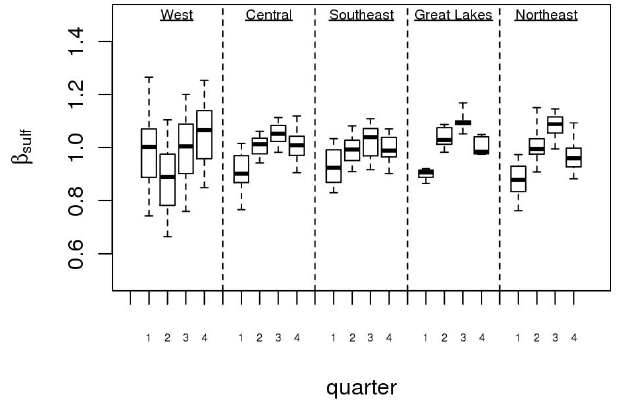
Fig. 9. Spatial and temporal trends in β sulf .